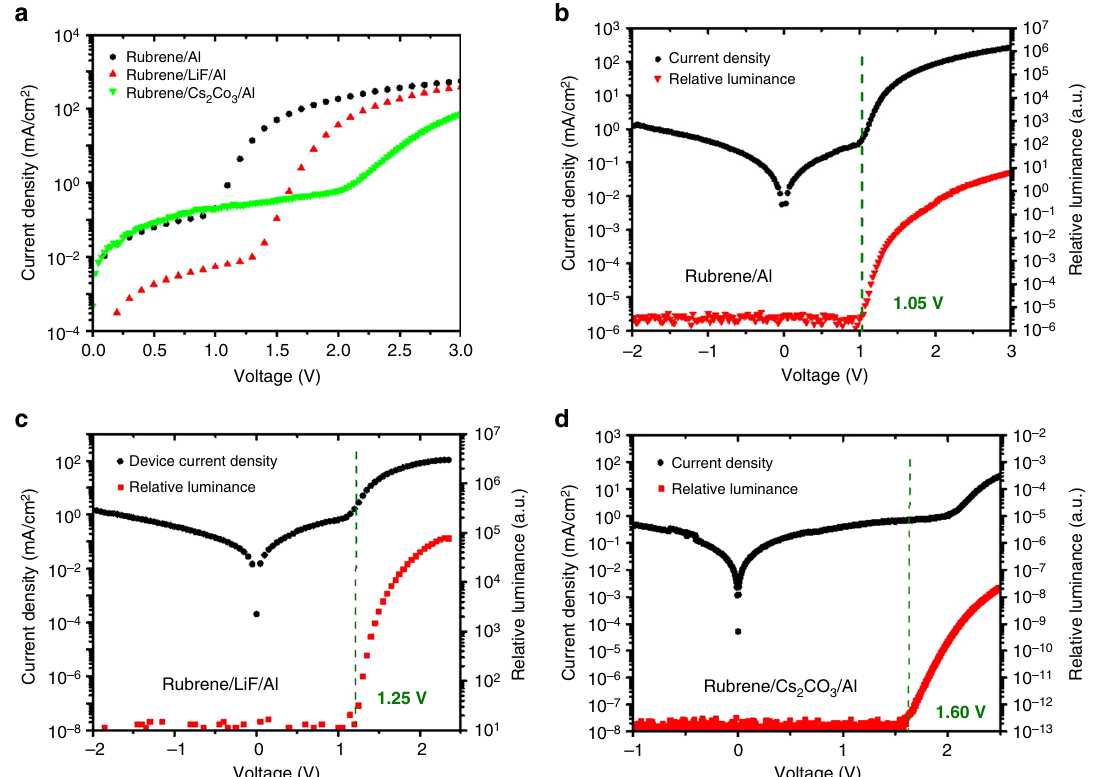
Fig. 4 Electrical characteristics of different rubrene devices. a Current density as a function of voltage of rubrene single-layer OLEDs. b – d Current density and relative luminance versus voltage of the devices with Al, LiF/Al and Cs 2 CO 3 /Al